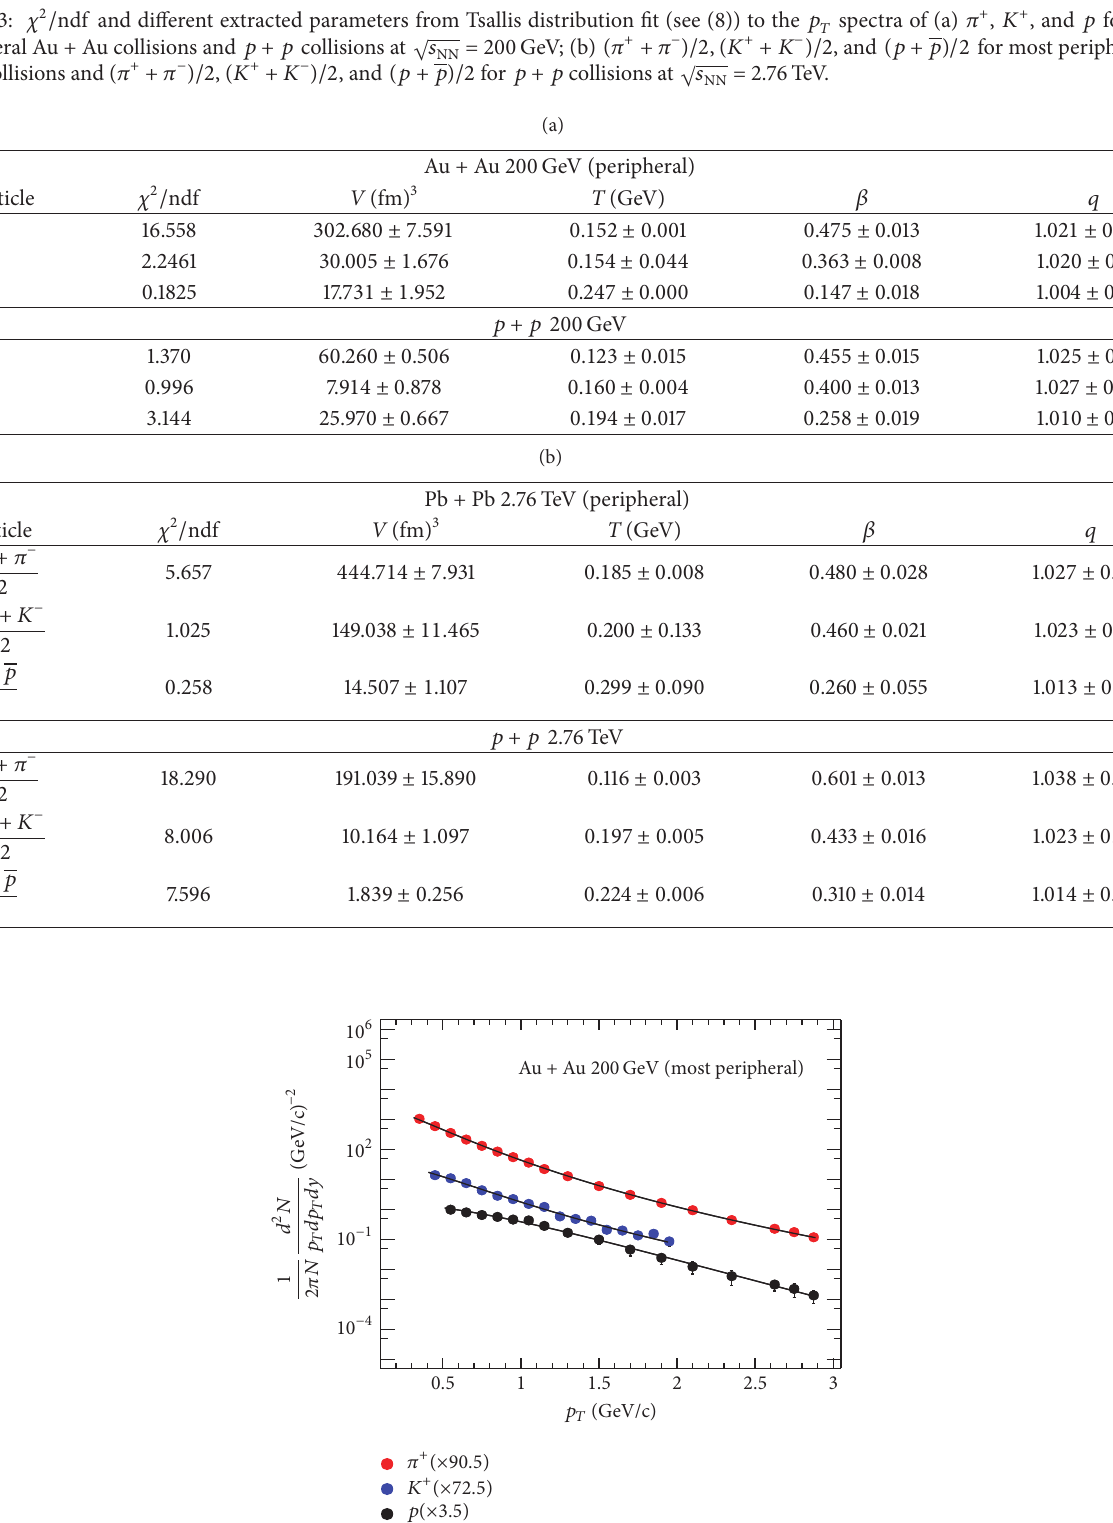
Table 3: 𝜒 2 / ndf and different extracted parameters from Tsallis distribution fit (see (8)) to the 𝑝 𝑇 spectra of (a) 𝜋 + , 𝐾 + , and 𝑝 for most peripheral Au + Au collisions and 𝑝 + 𝑝 collisions at √𝑠 NN = 200GeV; (b) (𝜋 + + 𝜋 − )/2 , (𝐾 + + 𝐾 − )/2 , and (𝑝 + 𝑝)/2 for most peripheral Pb